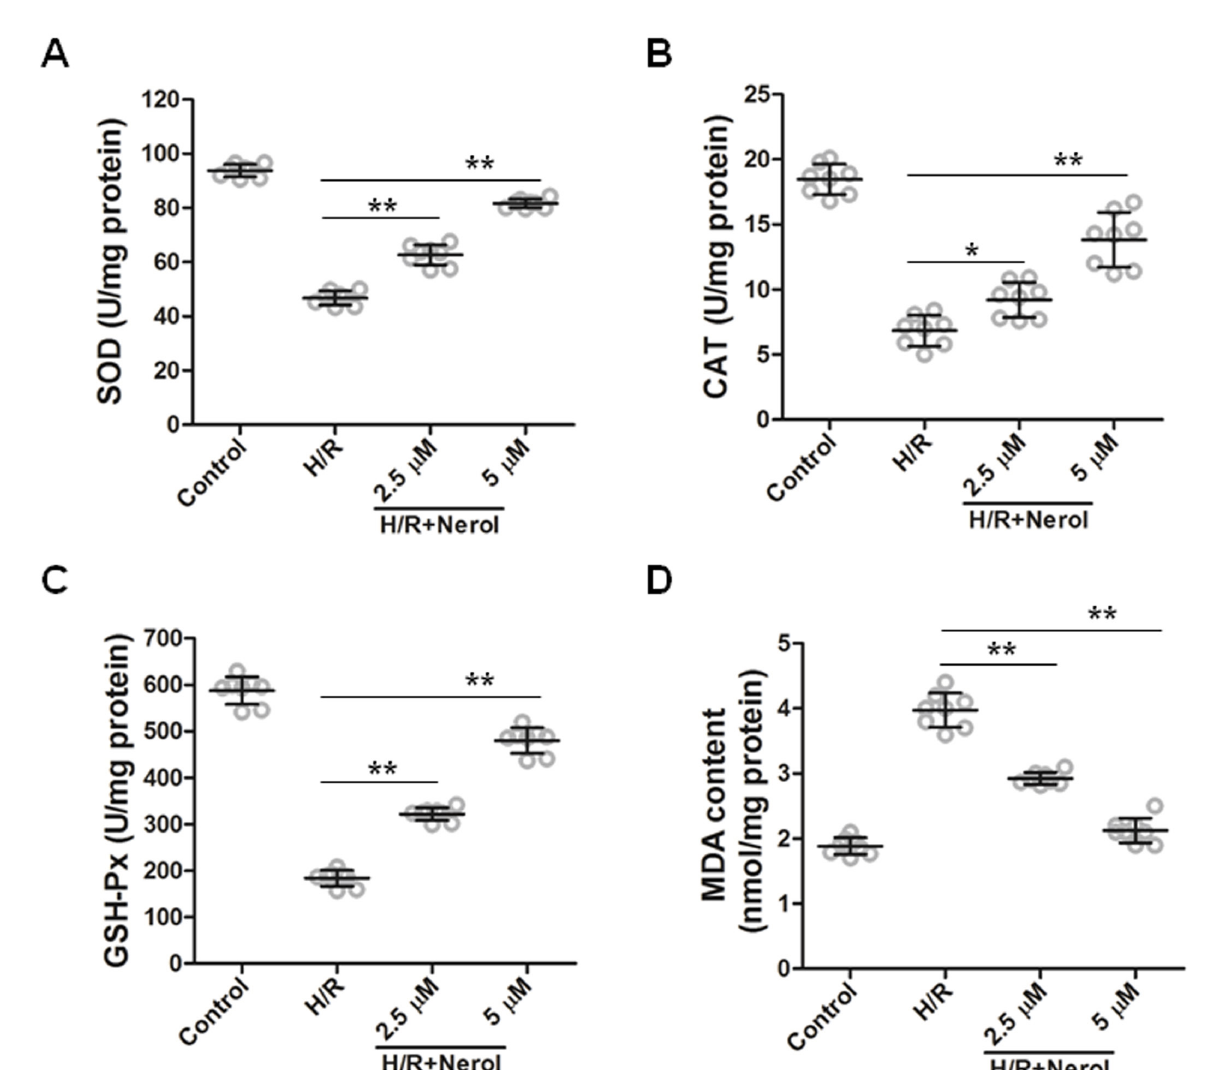
Figure 2. Nerol suppresses H/R-induced oxidative stress in cardiomyocytes. H9c2 cardiomyocytes were treated with 2.5 μM or 5 μM Nerol, followed by H/R treatment for 12/12 h. The activities of SOD (A), CAT (B), GSH-Px (C) and MDA content (D) were measured in H9c2 cardiomyocytes. n=8. p<0.05 (*), p<0.01